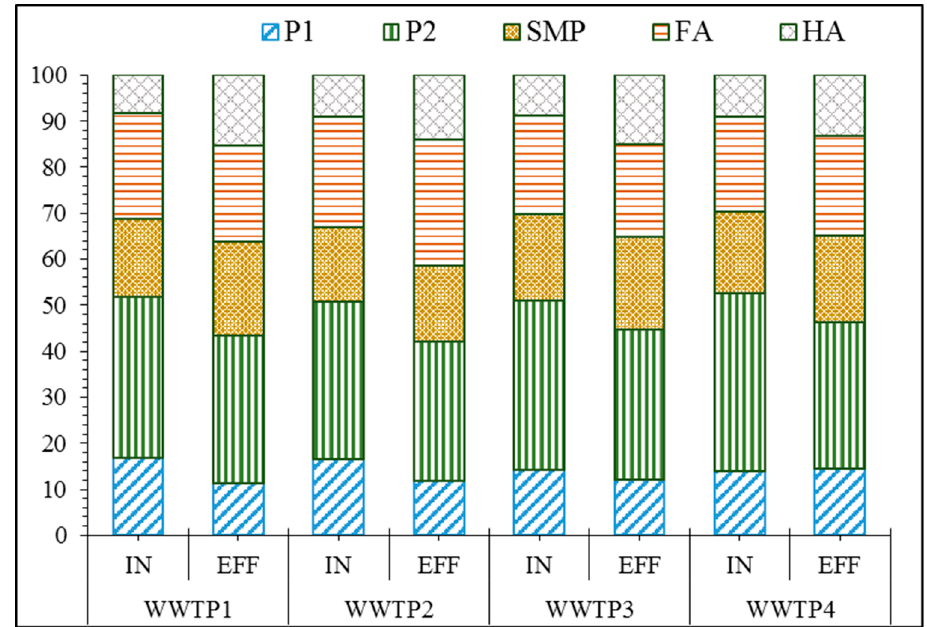
Figure 2. The average abundance percentages of five identified regions in influent and effluent wastewater samples across all four study wastewater treatment plants (WWTPs). P1 and P2 refers to aromatic protein; FA: Fulvic Acid-like; SMP: Soluble Microbial by-product-like; HA: Humic Acid- like.